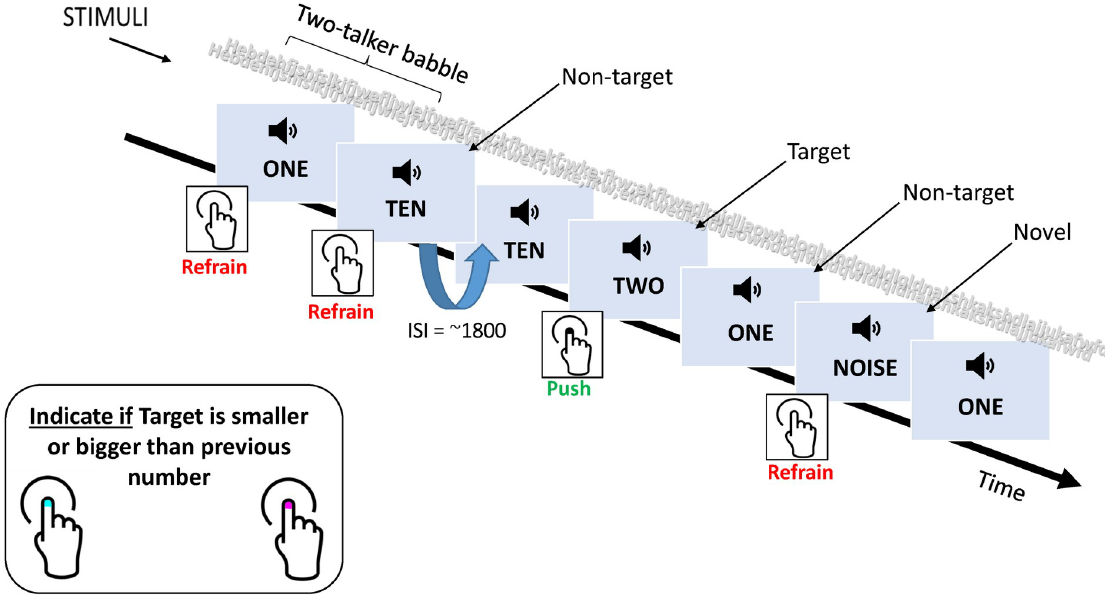
Fig 1. Example of task and sequence of events per trial, including time and auditory